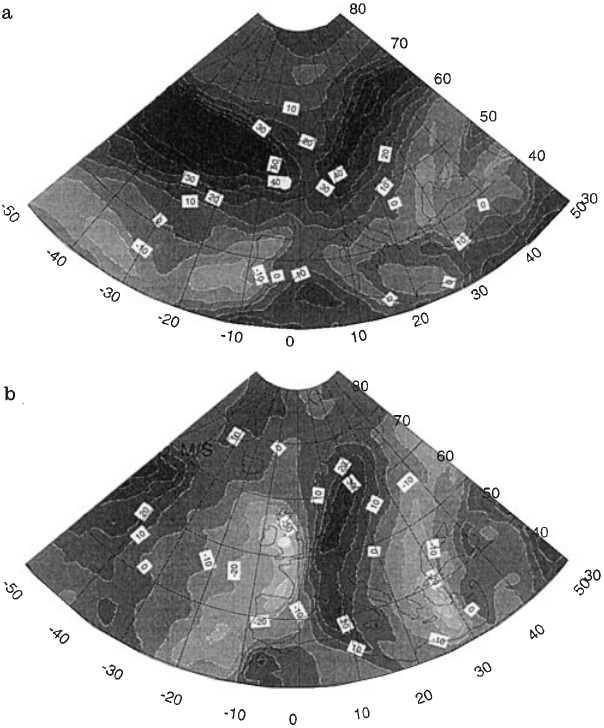
Fig. 3a, b. Contour plots of horizontal wind velocities in m/s for the 315 K isentrope level, as given by the ECMWF operational analysis at 1200 UT on 12 March, 1994, for a zonal component and b meridional component, in which the position of Aberystwyth (52.4 (cid:176) N, 4.1 (cid:176) W) is indicated by a white